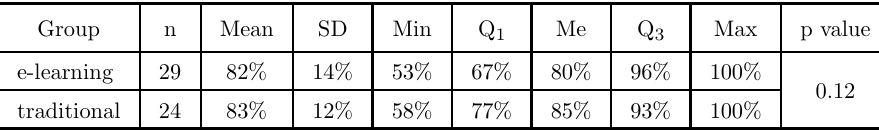
Table 3. Final results (%) of the subject “Problems of multiculturalism in medicine” Group